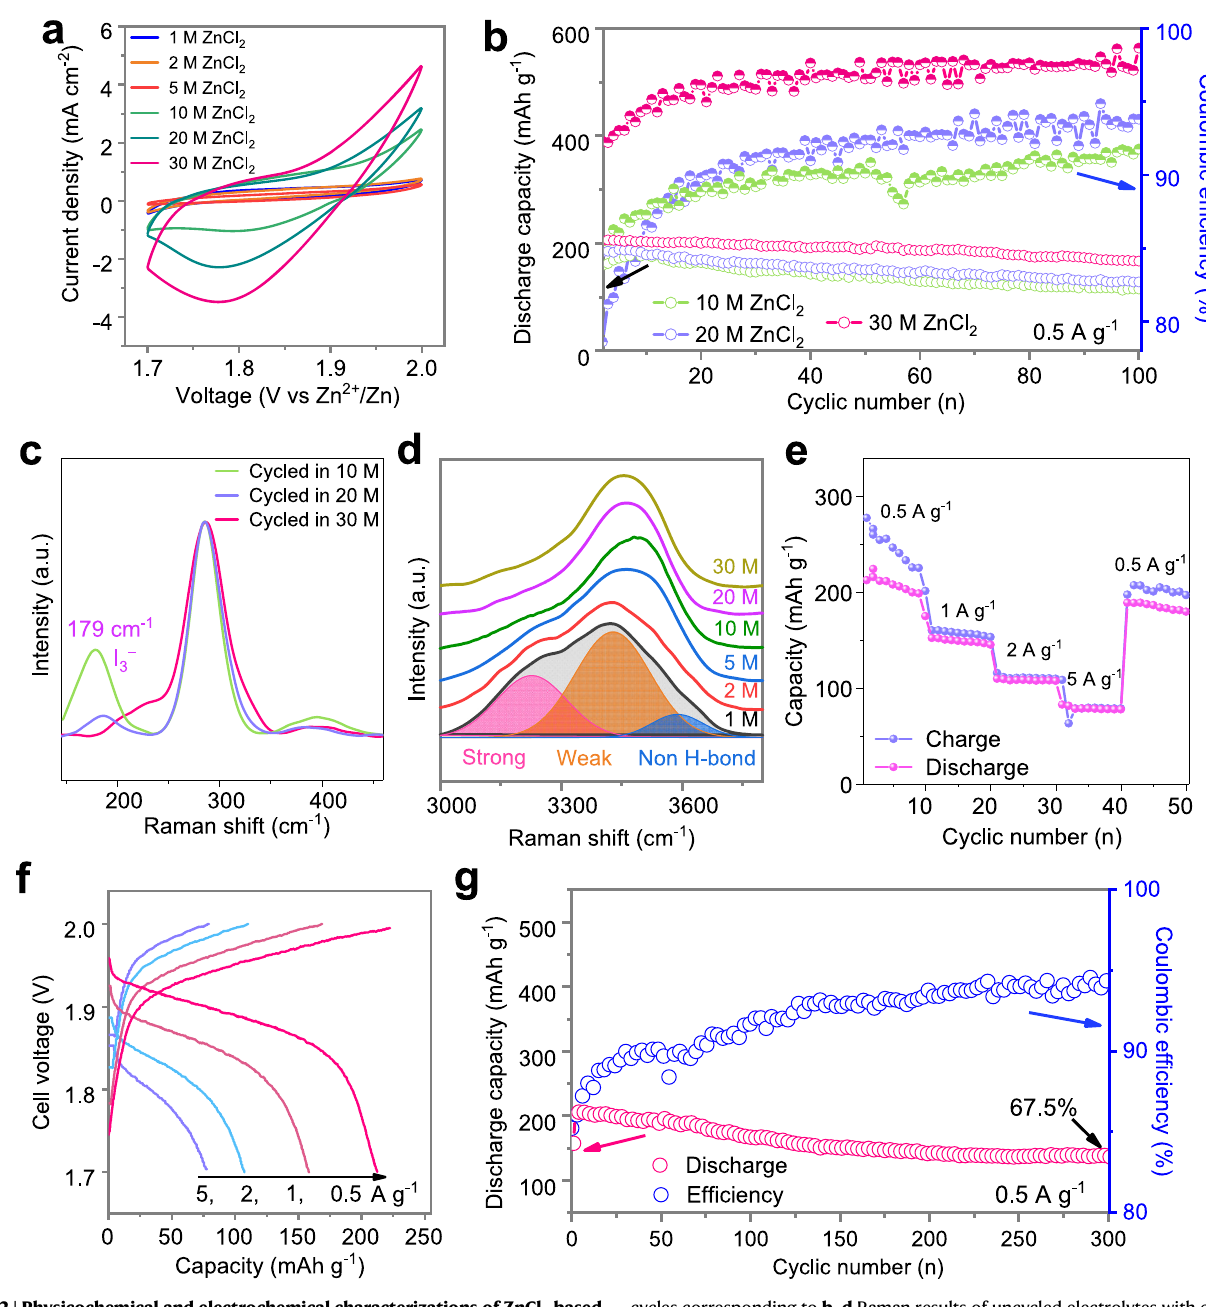
cycles corresponding to b . d Raman results of uncycled electrolytes with different concentrations, in which the deconvolution peaks of strong hydrogen bonds (H- bonds), weak H-bonds and non-H-bonds are centred at 3228cm − 1 , 3432cm − 1 , and 3594cm − 1 ,respectively,forthe1mZnCl 2 electrolyte. e RateperformanceofZn||Cl- Icellsfrom0.5to0.5Ag I2 -1 andthecorrespondingGCDcurves f . g Cyclingstability of the Cl-redox reaction after 300 cycles at 0.5A g I2 -1